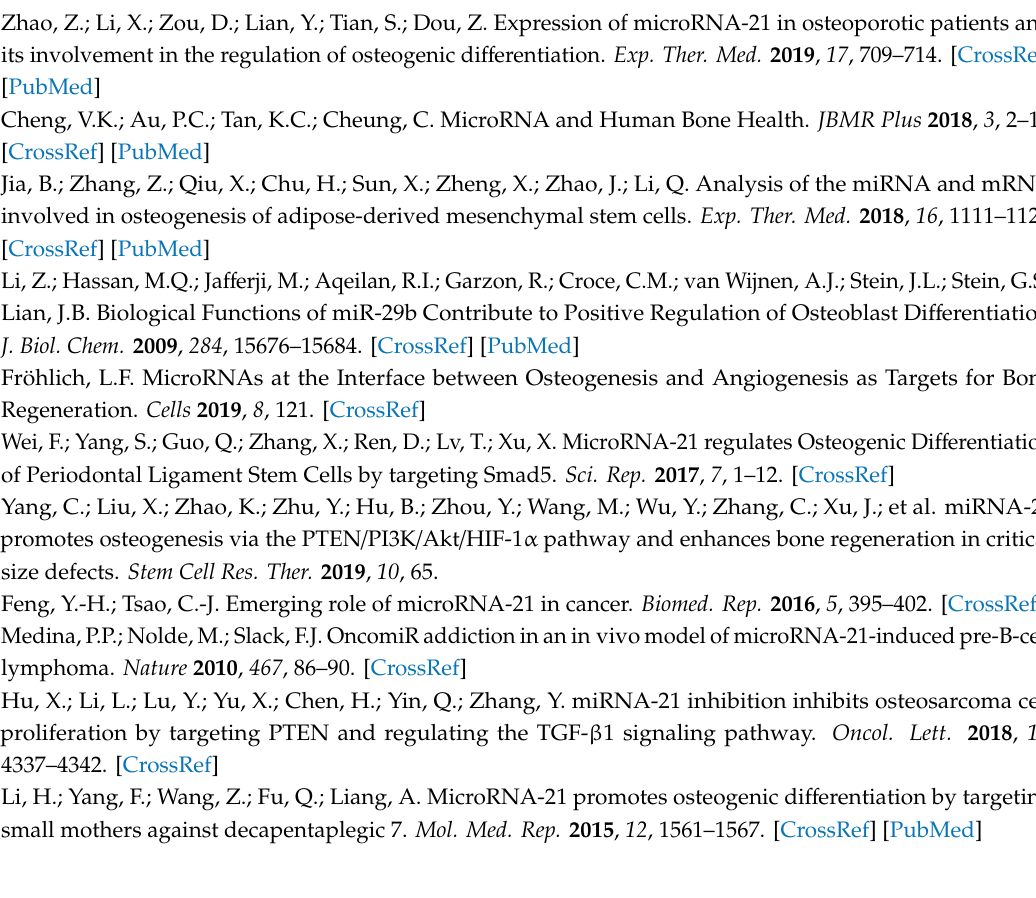
Table S1. Sequences of the primers used in the experiment. Figure S1. Analysis of e ff ectiveness of miR-21 inhibition in MC3T3 cell line. Figure S2. The influence of transfection with miR21 inhibitor on MC3T3 proliferative activity. Figure S3. The results showing a specific action of miR-21 inhibitor in osteogenic cultures. Figure S4. The analysis of calcium (Ca) and phosphorus (P) content deposited in extracellular matrix formed by MC3T3. Figure S5. The influence of miR-21 inhibition on TRAP expression in the MC3T3